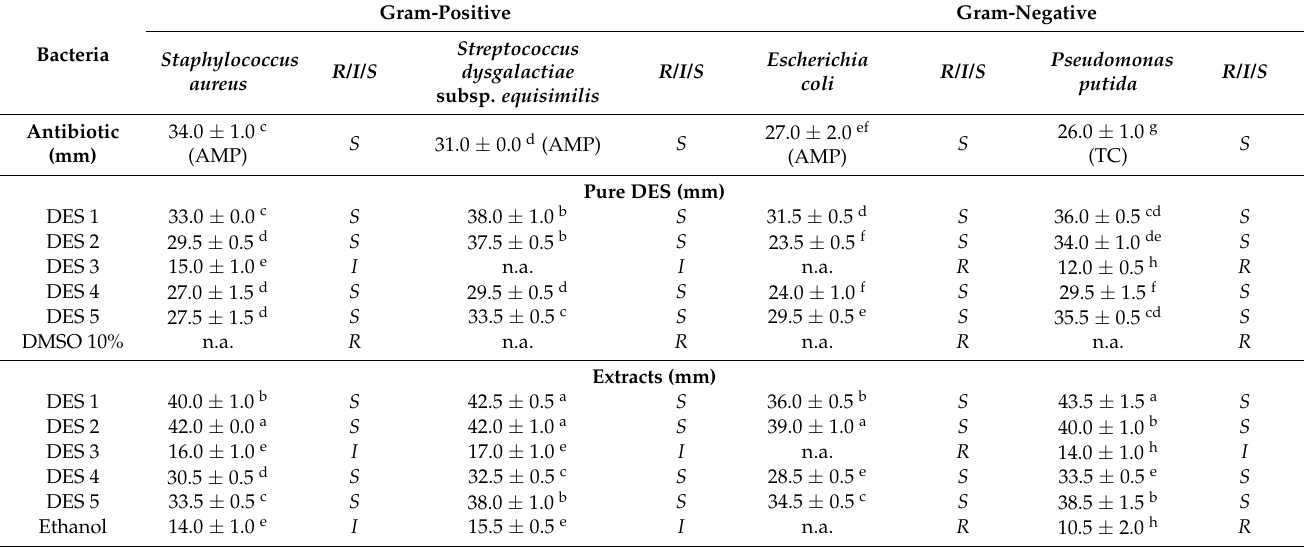
Table 5. The antibacterial capacity of phenolic extracts from avocado peel and pure